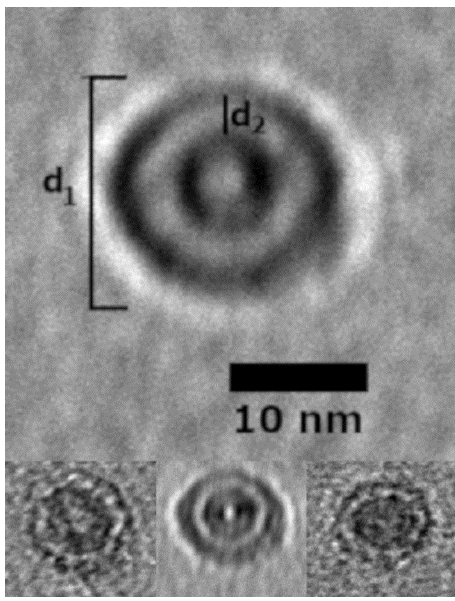
Figure 2. Selected stab-1 HCC doughnut-like images of oligomers obtained from TEM data. Top, enlargement of the images of stab-1 HCC oligomers observed by TEM. The diameter is indicated by “d 1 ” and the distance between the inner and outer rings defined as “d 2 ”. Bottom, variations in d 1 and d 2 are likely to be due to the differences in the electron density of the contrasting uranyl acetate adsorbed to the oligomer surface. Scale bars are 10 nm in each case.